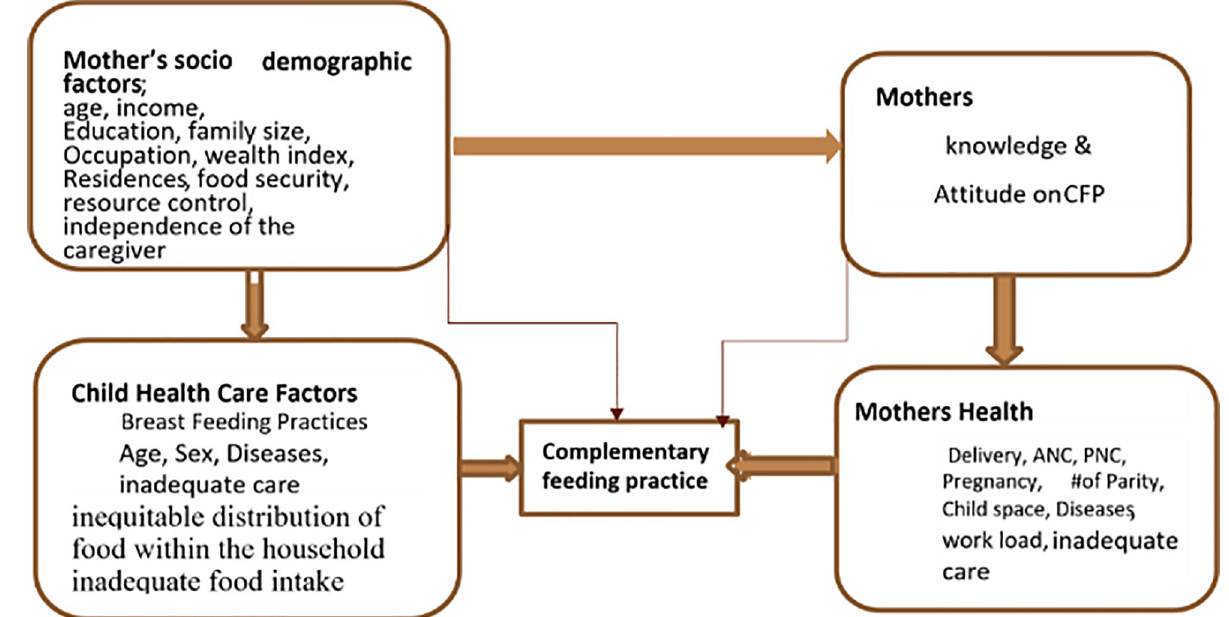
Fig 1. Conceptual frame work of complimentary feeding practice from different literature review, 2020. CFP: Complementary feeding practices, #: number, ANC: Antenatal care, PNC: Postnatal care.